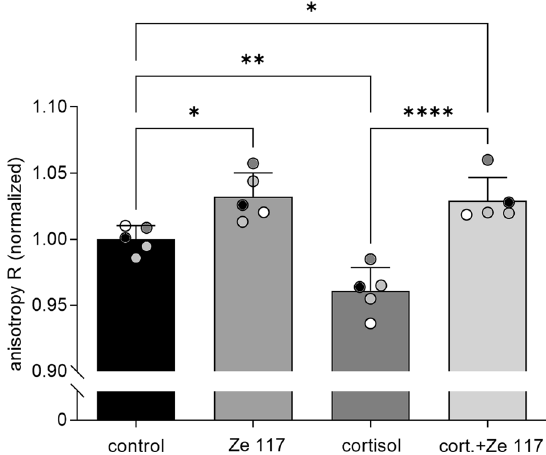
Fig. 2 Fluorescence anisotropy of untreated PBMC (control) and after treatment with 1 µM cortisol, 50 µg/ml Ze 117 and combination of 1 µM cortisol with 50 µg/ml Ze 117 using 2.5 µM DPH. Results of five independent experiments are presented as mean standard deviation. *Marked values are significantly different ± from corresponding control with p < 0.05 (**p < 0.01, ***p < 0.001, ****p < 0.0001) determined by one-way ANOVA (n Holm-Šídák